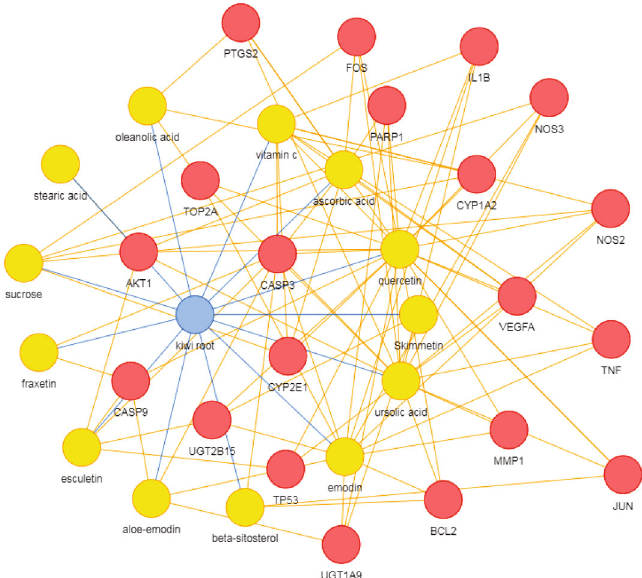
Figure 1: The component-target-disease network of RAC for RCC. Yellow circles represent the compound; red cycles represent the targets. Note: RAC: Radix Actinidia chinensis; RCC: renal cell